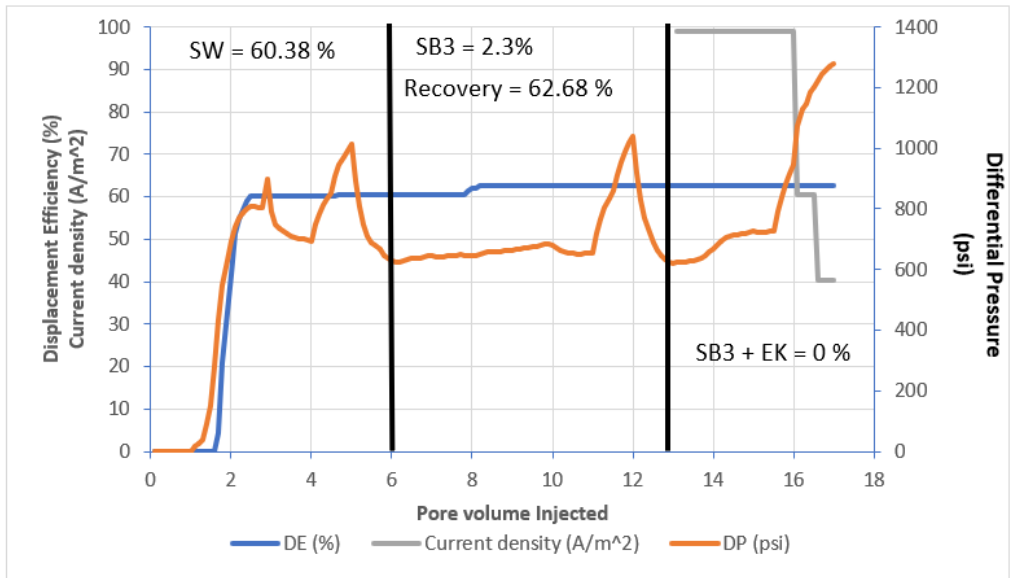
Figure 5. DE, DP (ΔP), Current Density vs. Pore Volume Injected for CF4 . Figure 5. DE, DP ( ∆ P), Current Density vs. Pore Volume Injected for